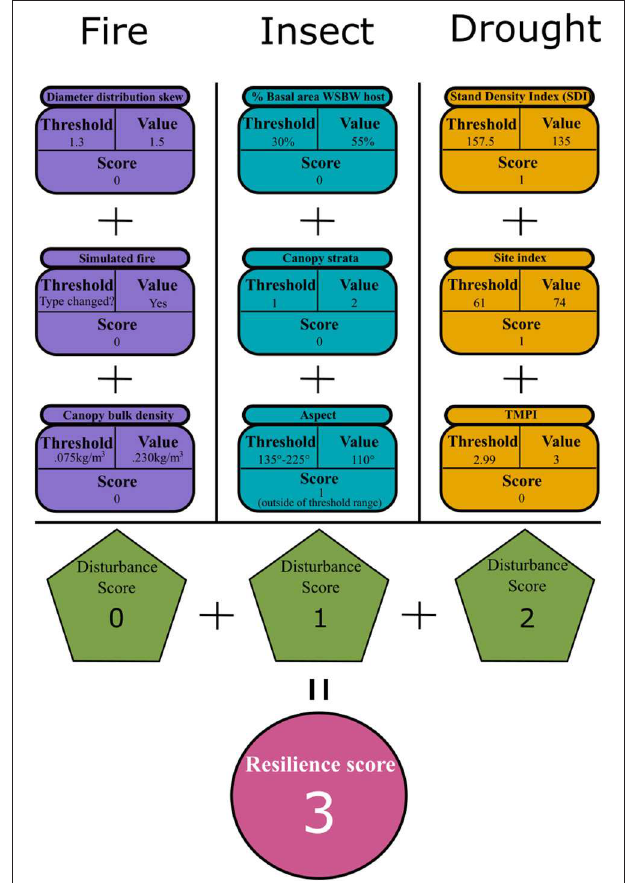
FIGURE 2 | Diagram showing how the resilience score is calculated for a hypothetical dry mixed conifer stand. Indicators of potential resilience to each disturbance (Purple, Blue, Orange) are compared to threshold values and assigned a score of 0 or 1 depending on the indicators’ contribution to potential resilience. Scores for each indicator are summed to give a resilience score for each disturbance (Green). The total resilience score for the stand (Pink) is the sum of scores from each